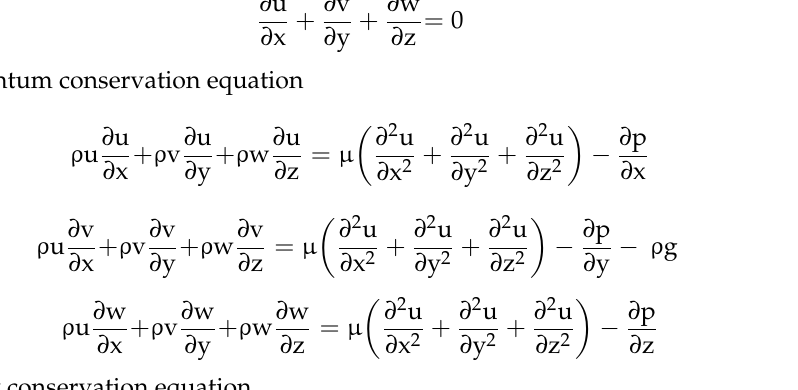
Table 3. Inlet boundary conditions for ventilation dilution simulations.